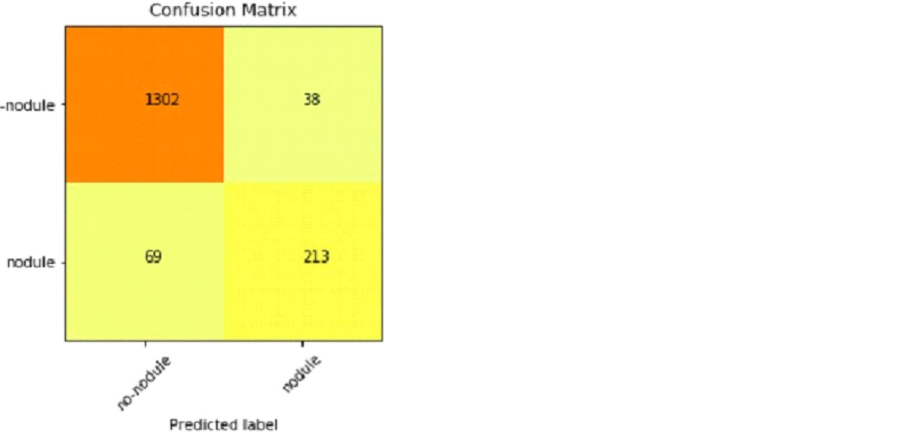
Figure 15. Confusion matrix of CNN2.